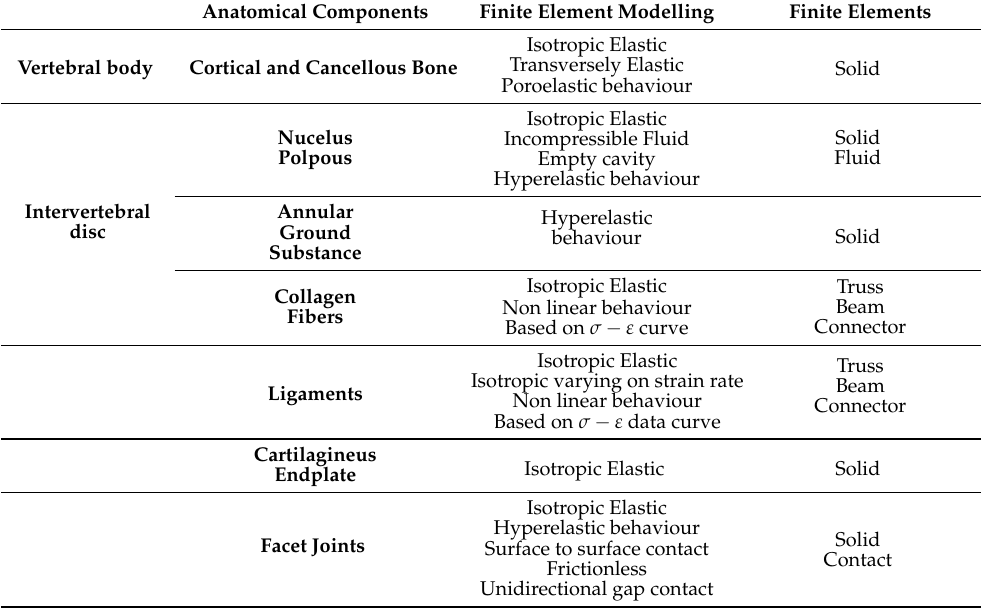
Table 2. FE modelling and elements of the different anatomical components [14,15,21,24,36–62]. Anatomical